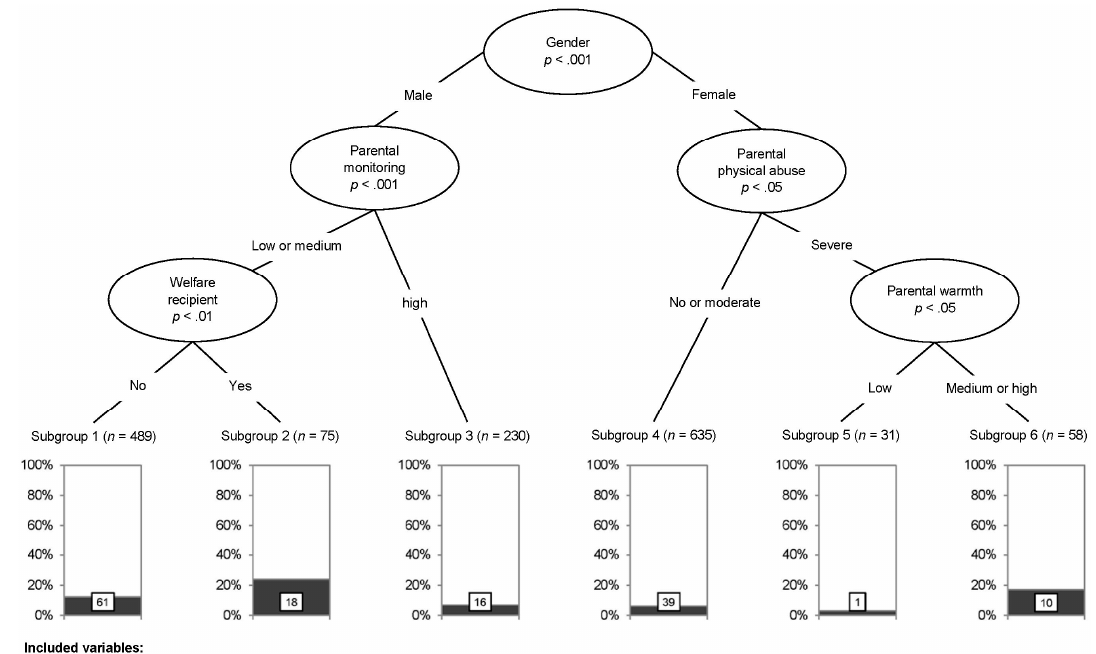
Figure 2. Conditional inference tree plot predicting adolescent overweight/obesity by gender, immigrant background, socioeconomic status (SES; welfare dependency), parental physical abuse, warmth and monitoring in childhood ( n = 1518). The rectangles on the bottom represent the six subgroups of students computed by C-Tree (the share of overweight/obese students is marked in black). Summarizing the overweight/obese students in the six subgroups results in the total number of overweight/obese students ( n = 145) in the sample. The three subgroups with a heightened risk of overweight/obesity are subgroups 1, 2 and 6. Subgroup 1 and 2 represent male students having